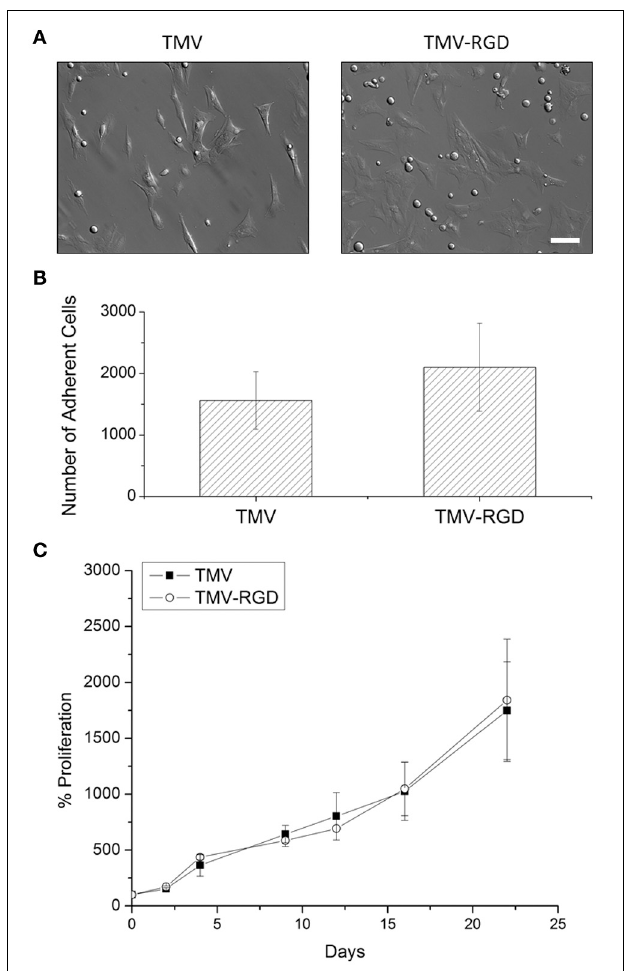
FIGURE 3 | BMSC adhesion and viability on virus scaffolds. (A) Optical images of BMSC attached on virus substrates after 24-h seeding in primary media. Scale bar is 100 μ m. (B) Number of adherent BMSCs on different virus substrates after 24-h seeding in primary media. (C) Proliferation percentage of BMSCs on TMV and TMV-RGD substrates over 22 days in osteogenic media. Error bars indicate ± 1